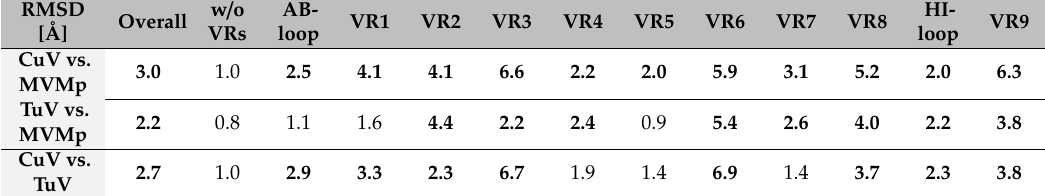
Table 2. Overview C α RMSDs for the superposed CuV, TuV, and MVMp VP